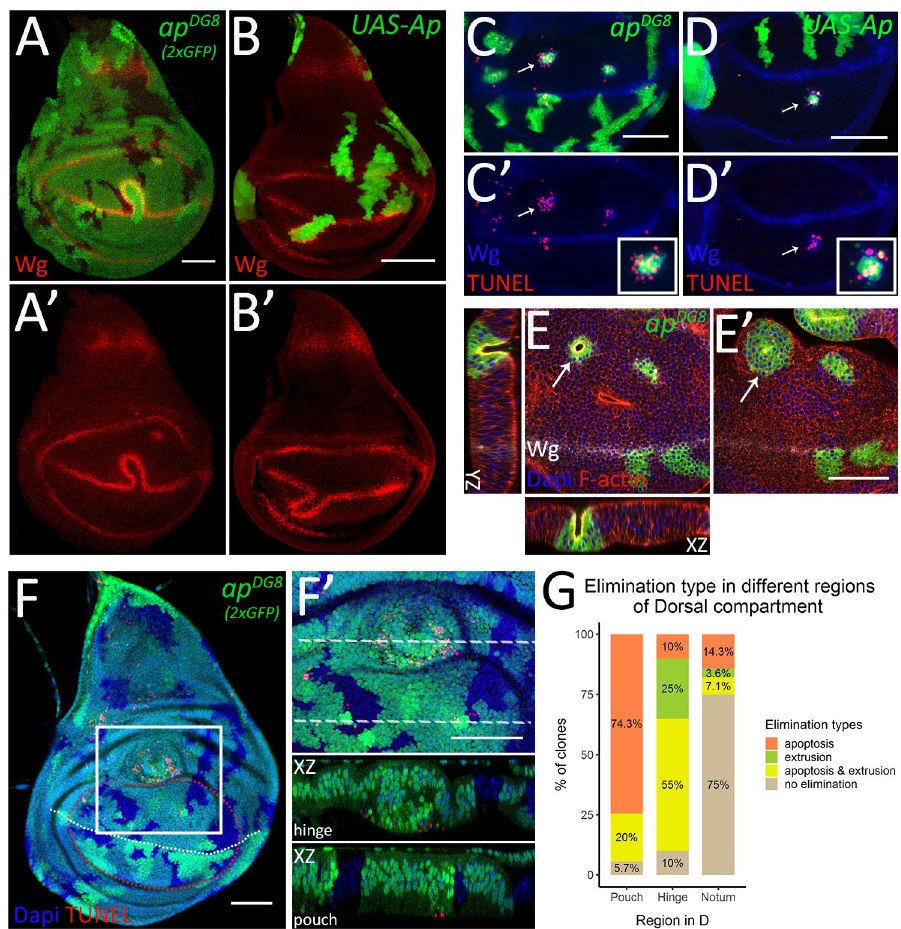
Fig 4. Mechanisms of the elimination display region specificity. (A-B) Third instar wing discs with ap DG8 (A) or Ap- expressing (B) clones displaying D/V boundary deformation and clone relocation. (A’-B’) Wg channel of A-B. (C-D) TUNEL assay of third instar wing discs with ap DG8 MARCM (C) or Ap-expressing (D) clones. The pouch regions are shown. (C’-D’) Wg and TUNEL channels of C-D. The insets show enlarged images of single representative clones defined by arrows. (E-E’) Pouch region of the third instar wing disc with ap DG8 clones shown from the apical (E) and the basal (E’) sides. The arrows point to the bulging clone. The XZ and YZ planes throughout the bulging clone are also shown (XZ orientation: the apical side–up, YZ orientation: the apical side–right). (F-G) Mechanisms of elimination display region-specificity. (F) Third instar wing disc containing ap DG8 mitotic clones (marked by 2 copies of GFP) that remained at 50h AHS. White dashed line represents D/V boundary; red dashed line outlines the pouch region (based on the most proximal fold). (F’) Zoom-in of the region defined by white square in F. The XZ cross-sections throughout the clones located in the hinge and the pouch are shown below (orientation: the apical side–up). (G) Quantification of dorsal mutant clones in different regions depending on the evidence of elimination type: apoptosis, extrusion or apoptosis together with extrusion. A total of 83 dorsal ap mutant clones from 23 discs were analyzed: 35 clones were in the pouch, 20 in the hinge and 28 in the notum. Scale bars represent 50 μ m.